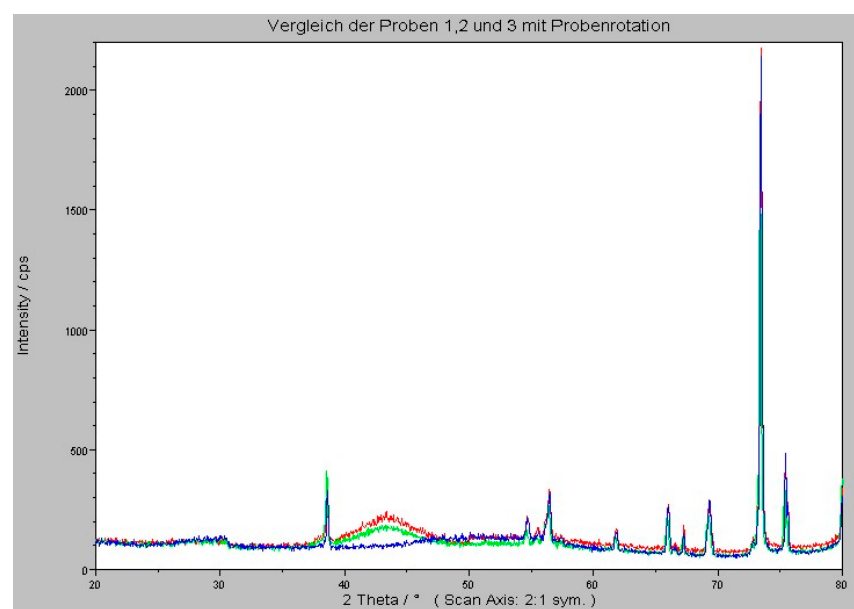
Figure 4. XRD analysis of samples after 100 h annealing at 500 °C in N 2 .